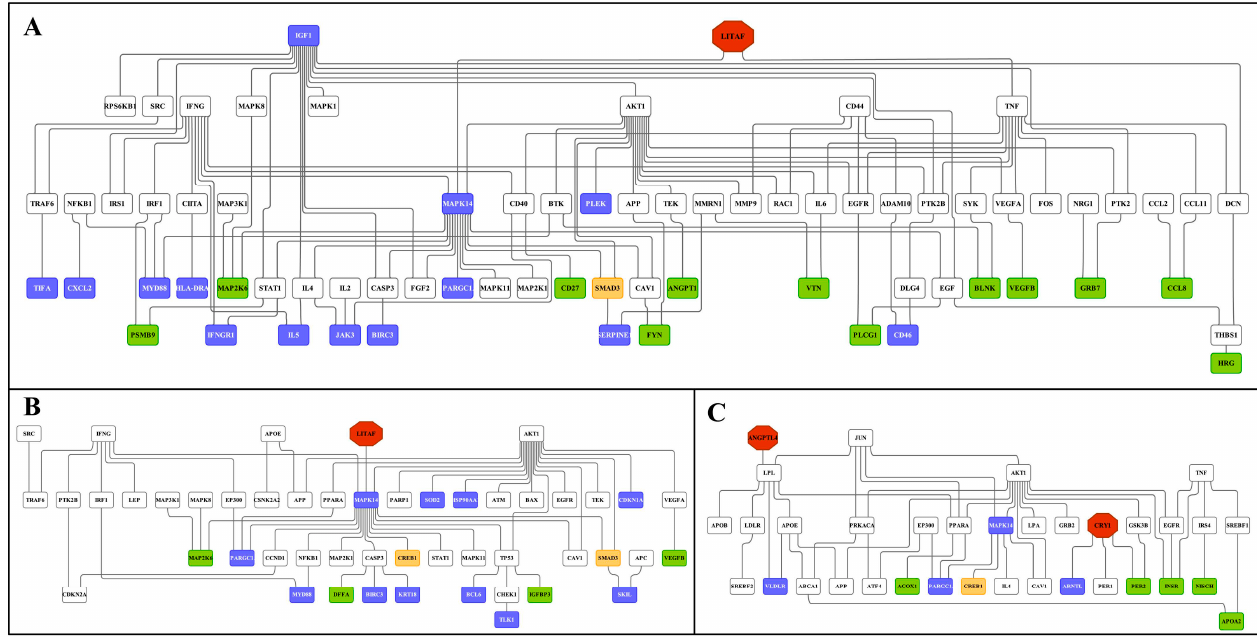
Figure 10. Master regulatory gene networks in the liver of high-dose diclofenac-treated animals. Based on interaction information available in the GeneWays database, master regulatory gene networks were constructed and fused using the GeneXplain platform. The red, violet, green, white and yellow nodes represent genes coding for master regulators, up-, down-regulated DEGs, connecting genes and enriched transcription factors, respectively. Panel A: Master regulatory network of immune and inflammatory response genes. Panel B: Master regulatory network of cellular stress and apoptosis-regulated genes. Panel C : Master regulatory network of genes involved in metabolic processes.